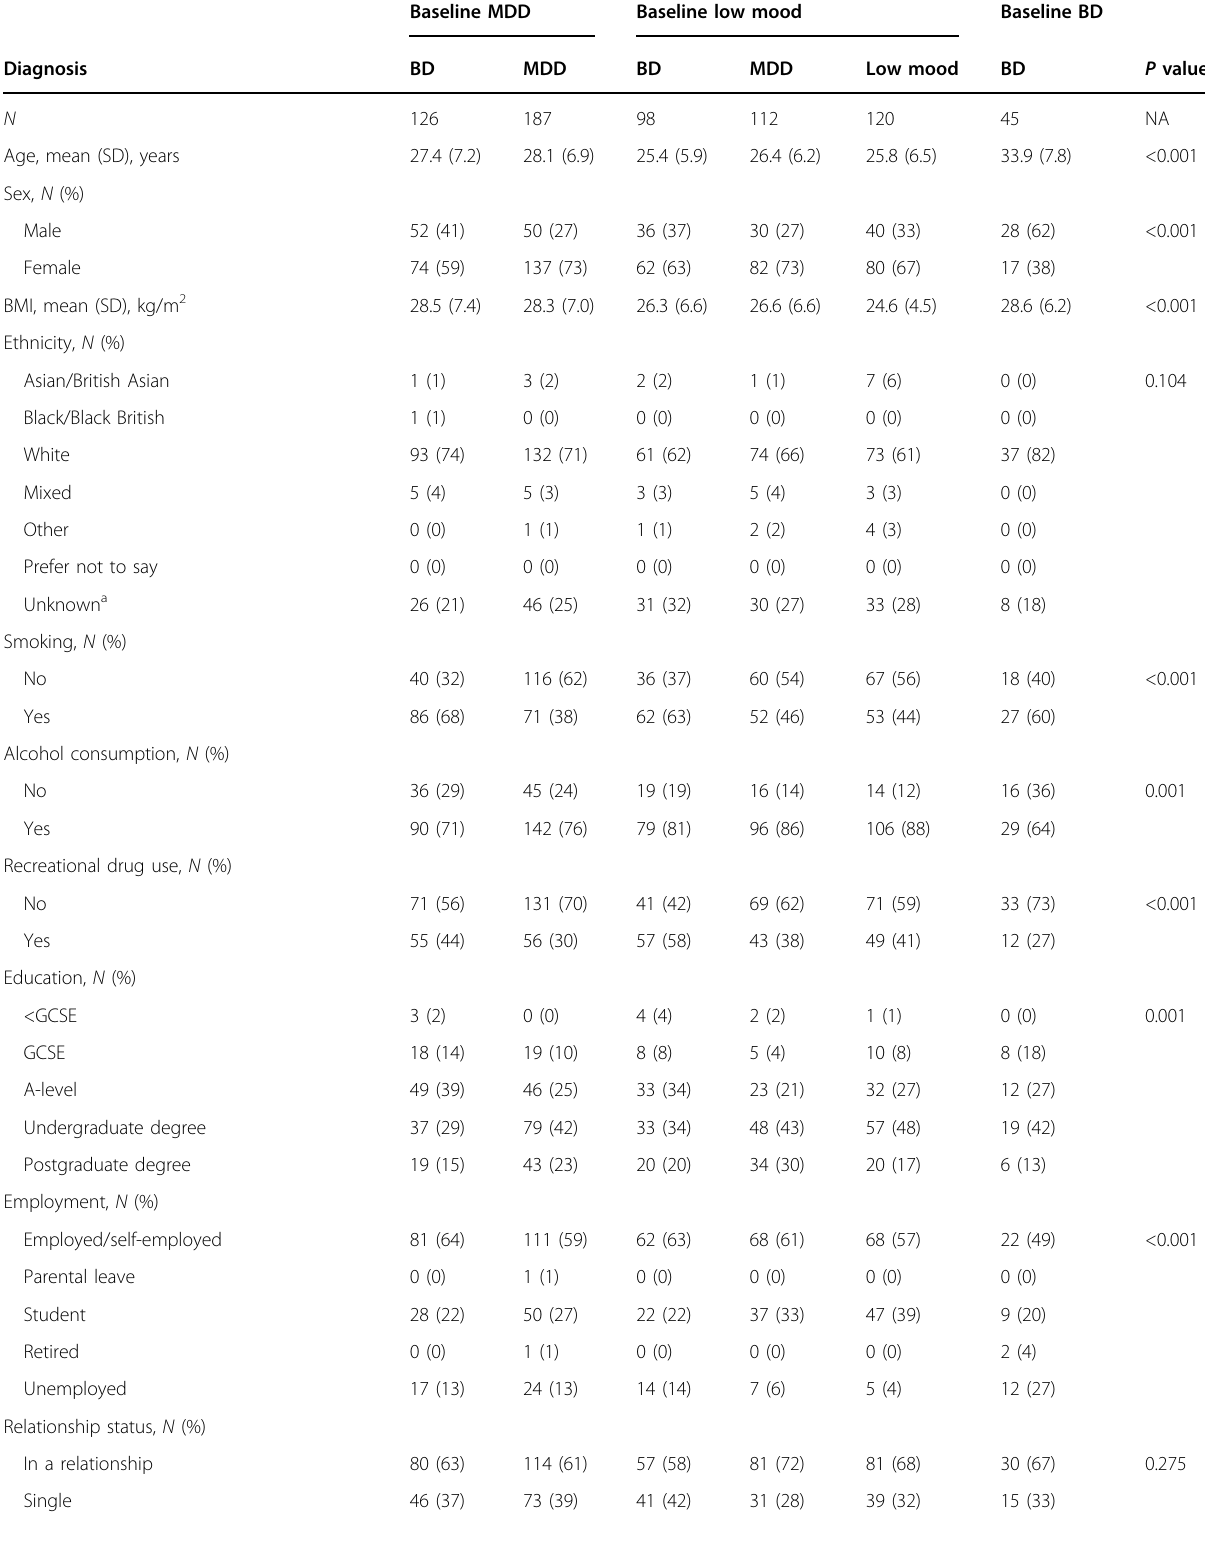
Table 1 Demographic and clinical characteristics of study